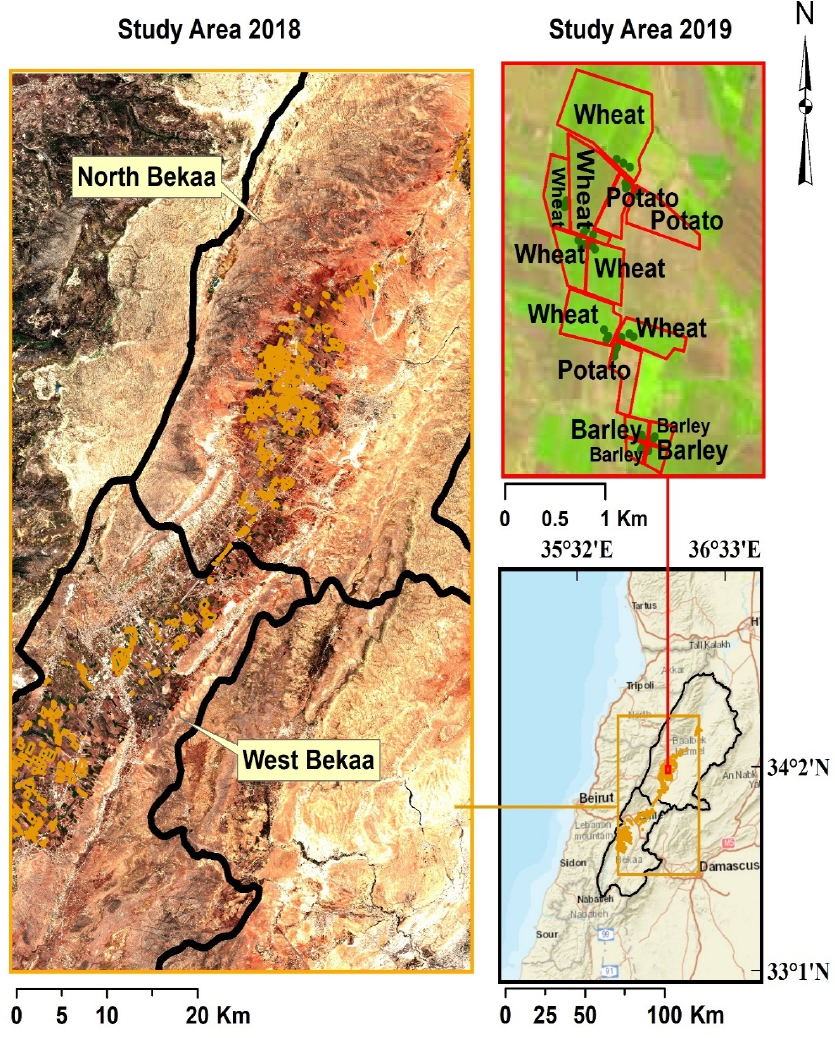
Figure 1. Location of the study area within the Bekaa Valley. Fields surveyed during the 2018 field campaigns are outlined in light orange, while fields surveyed in 2019 are outlined in red. LAI, canopy height, and above-ground biomass sampling sites (labeled in dark green) for the 2019 growing season, the color version of the study area map is available online. Remote Sens. 2020 , 12 , x FOR PEER REVIEW